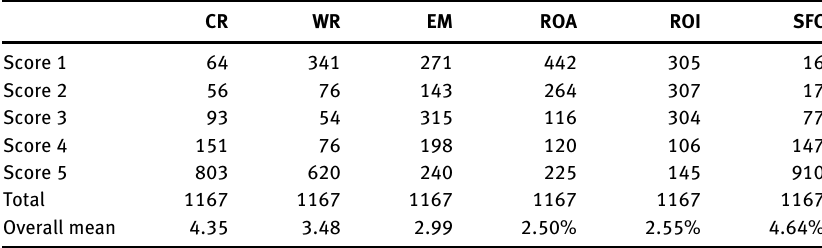
Table  : Score distribution within the SC sample, year  .